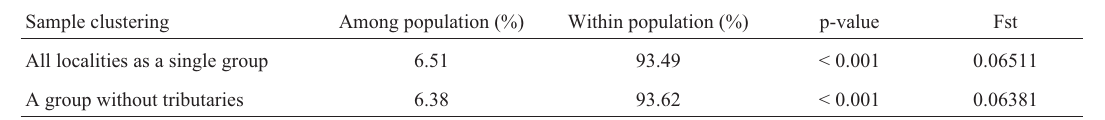
Table 3 - Molecular Analysis of Variance (AMOVA) in P. magdalenae distributed in 25 locations in the Magdalena River basin and its tributaries using seven microsatellite loci .